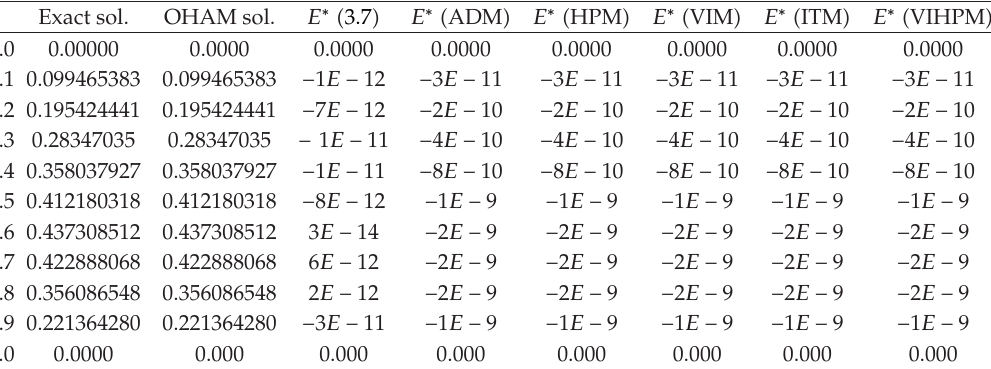
Table 1: It shows comparison of the solutions obtained by OHAM (cid:2) 3.7 (cid:3) , ADM (cid:7) 18 (cid:8) , HPM (cid:7) 20 (cid:8) , VIM (cid:7) 22 (cid:8) , ITM (cid:7) 24 (cid:8) , and VIHPM (cid:7) 21 (cid:8) . From the numerical results, it is clear that OHAM is more e ffi cient and accurate. x Exact